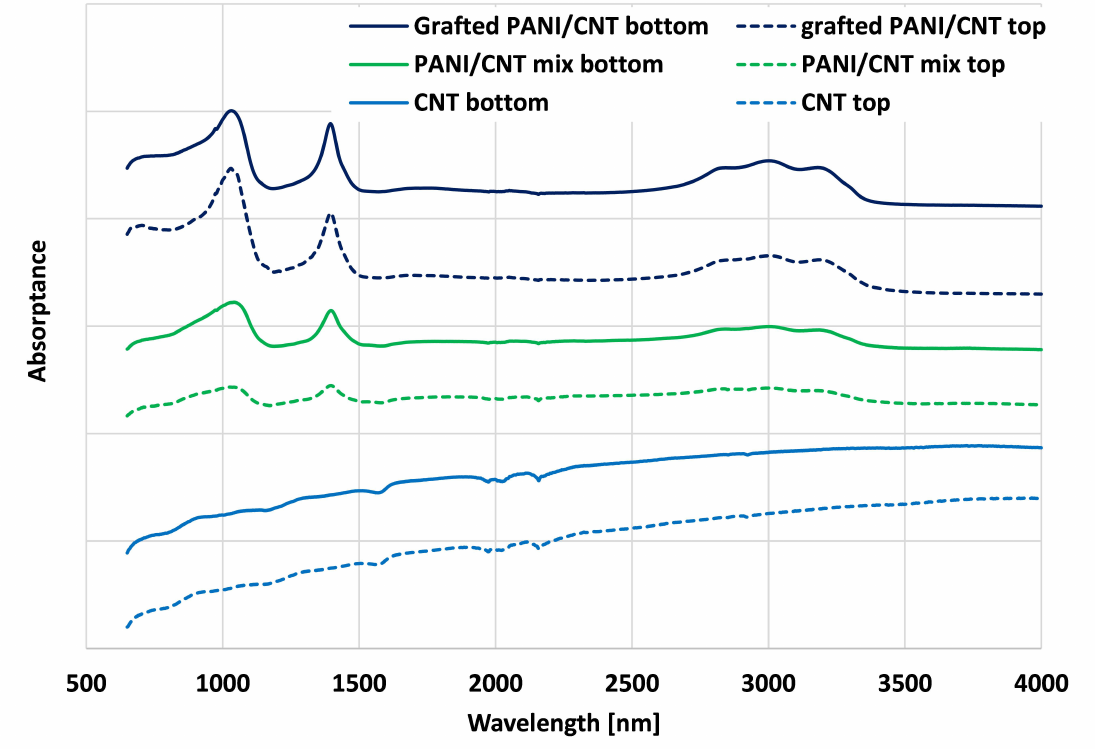
Figure2. Fourier-TransformInfrared(FTIR)spectraofneatCNT,PANI / CNTphysicalmixture, andPANI grafted CNT Bucky